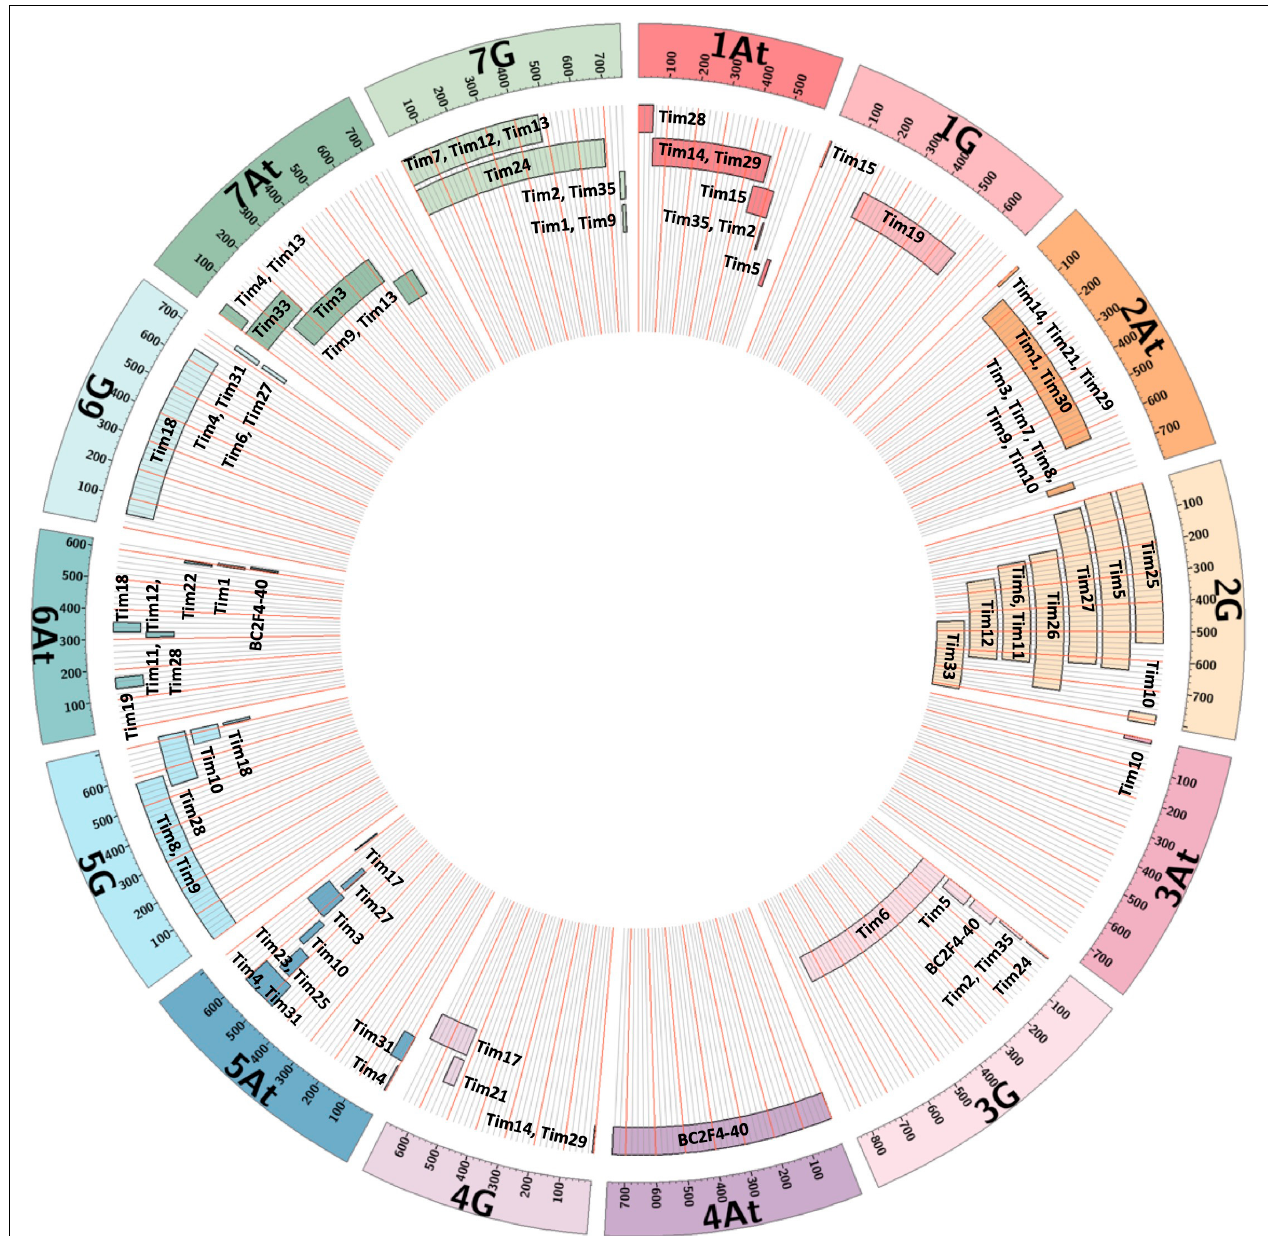
FIGURE 7 | Representation of T. timopheevii chromosome segments contained within each Tim introgression line showing approximate position and size of each segment relative to each T. timopheevii chromosome.